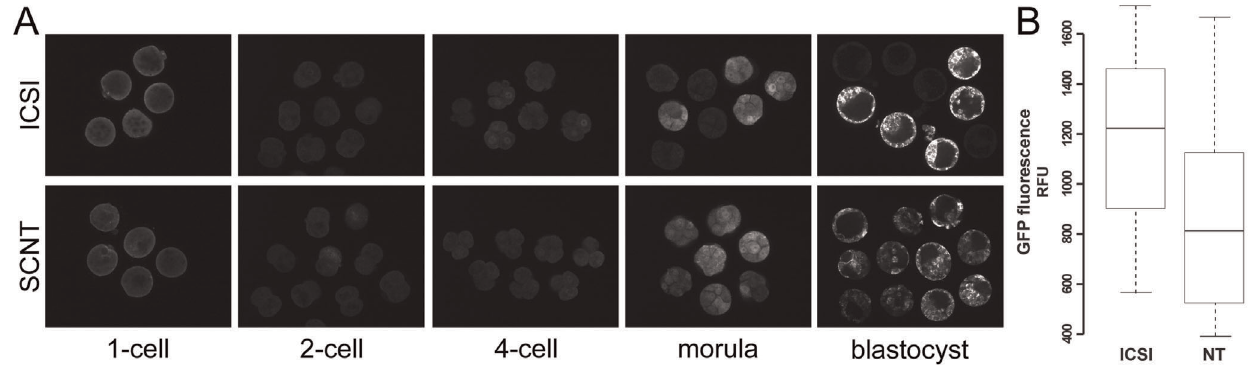
Figure 3. EGFP intensity in mtGFP-Tg embryos. B6C3F1 (wild-type) oocytes and ooplasts were used as recipients for mtGFP-Tg sperm or cumulus cell, for ICSI and SCNT, respectively. (A) Immunocytochemistry in ICSI and SCNT pre-implantation embryos revealed GFP expression onset at morula stage, and higher levels of GFP in ICSI compared to SCNT blastocysts. Hemizygosity of mtGFP-Tg mice results in EGFP-positive and negative ICSI embryos, while all SCNT embryos derive from EGFP-positive cumulus cell donors. (B) EGFP-specific signal quantification in mtGFP-Tg blastocysts confirmed higher EGFP protein levels in ICSI embryos (t-test, p =0.006). Box plot: fluorescence intensities distribution in the blastocyst; top and bottom lines: inter-quartile range; middle line: median; whiskers: range of variation limited to 1.5 times inter-quartile